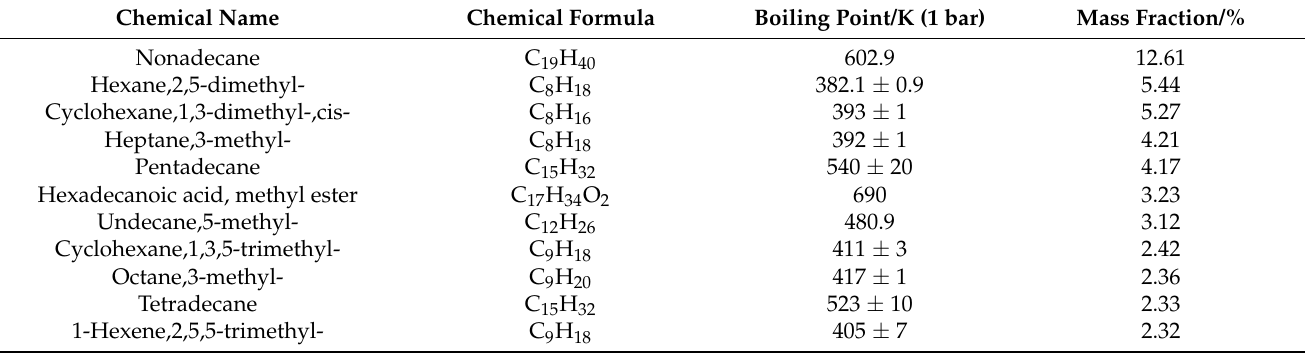
Table 1. RP-3 Aviation kerosene chromatography-mass spectrometry component ratio (>2%) [40].